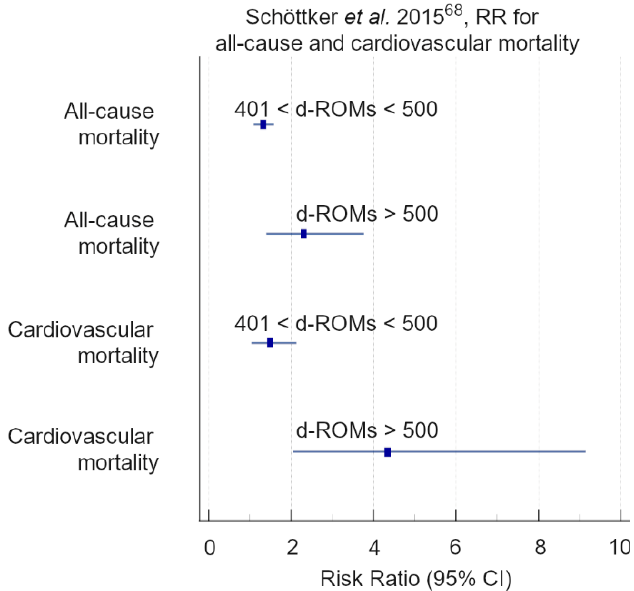
Figure 9. Graphical representation of the data reported in Table 3. The data were grouped depend- ing on clinical outcomes (all-cause mortality and cardiovascular mortality) and statistical parame- ters (RR), as reported in Schöttker et al., 2015 [68].